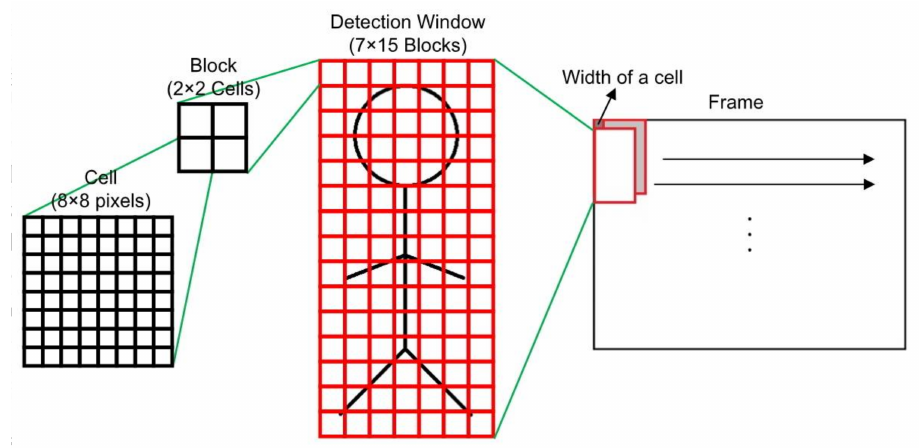
Figure 1. Division of a detection window in a frame in the proposed